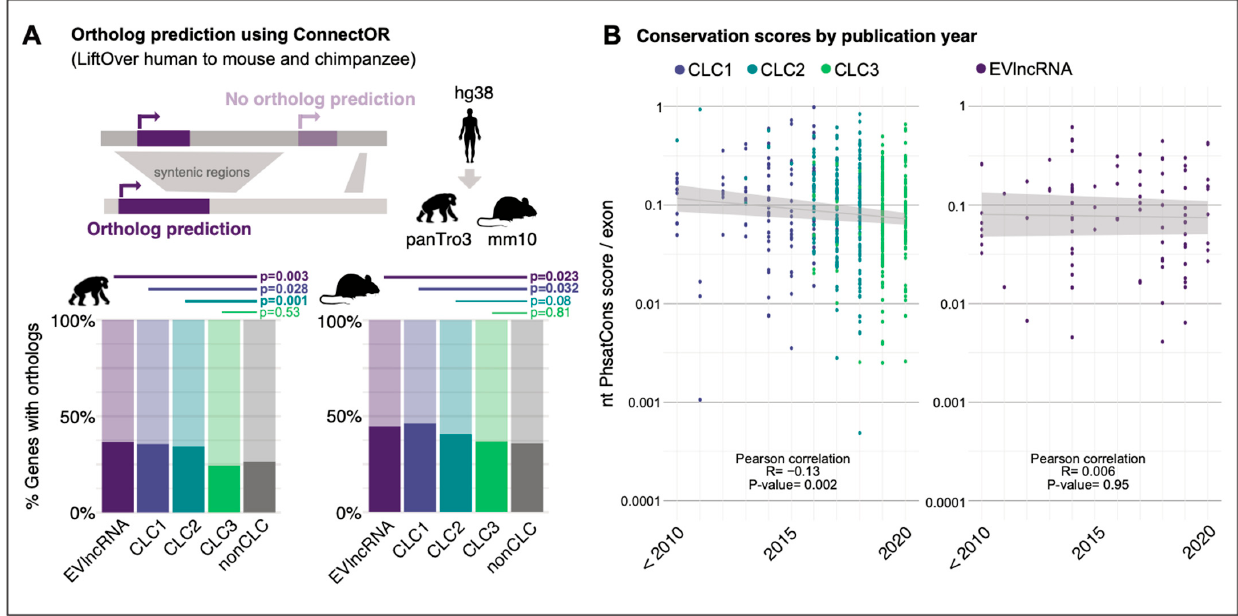
Figure 2. ( A ) Ortholog prediction using ConnectOR for chimpanzees (left) and mice (right). ( B ) Exon conservation scores by publication year for CLC versions (left) and EVlncRNAs (right).